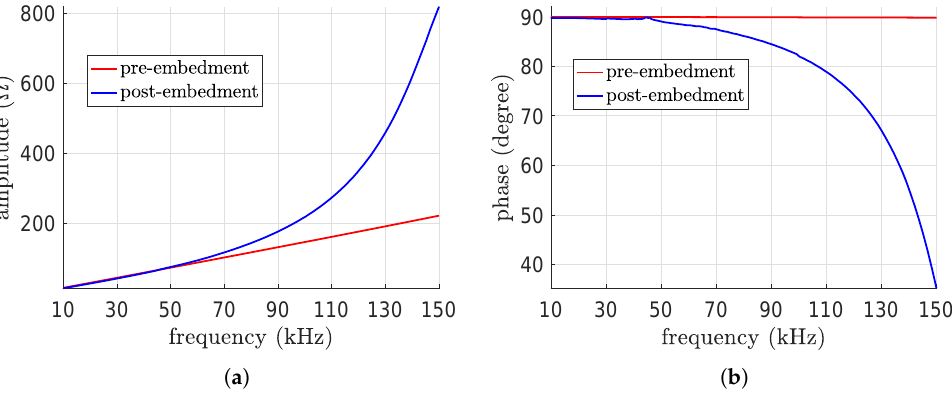
Figure 3. Comparison of amplitude and phase of the coil impedance before (pre) and after (post) embedment measured by means of the LCR meter. Amplitude ( a ); phase ( b